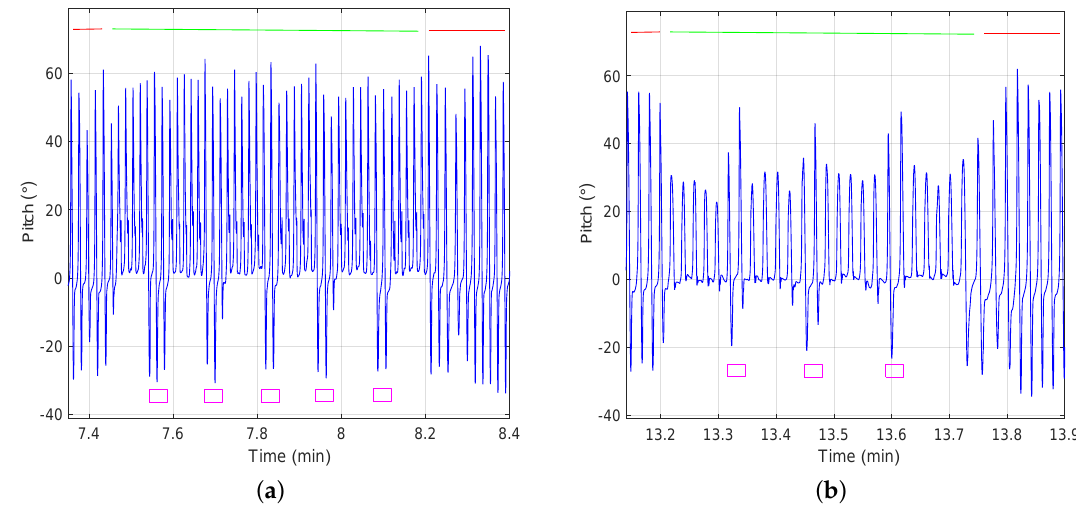
Figure 4. ( a ) Shows in blue the pitch estimation walking down stairs and ( b ) walking up stairs. The red upper line highlights the pitch estimation corresponding to walking horizontally and the green line highlights the pitch estimation walking on stairs. The magenta rectangles highlight the landing zone of the stairs, which corresponds to walking